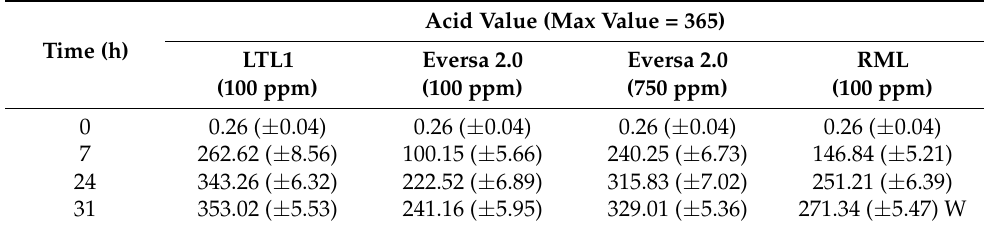
Figure 4. Hydrolysis of vinyl laurate (VL) and C8-C10 ME with LTL1 and commercially available lipases (TLL, RML, CALB, and Eversa 2.0). Over 15 min of reaction time, LTL1 outperformed other commercial enzymes with a normalised unit activity (U/mg) of about 11,000 and 3000 for vinyl laurate and C8-C10 ME, respectively. Table 1. Hydrolysis of C8-C10 ME by LTL1, RML and Eversa